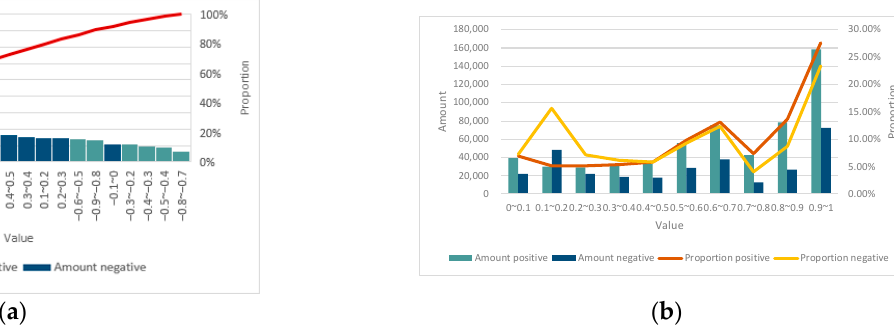
Figure 6. Number and percentage distribution of emotion scores: ( a ) Overall characteristics of the number of emotions distribution display; ( b ) Internal emotional intervals and polarity differences distribution display.